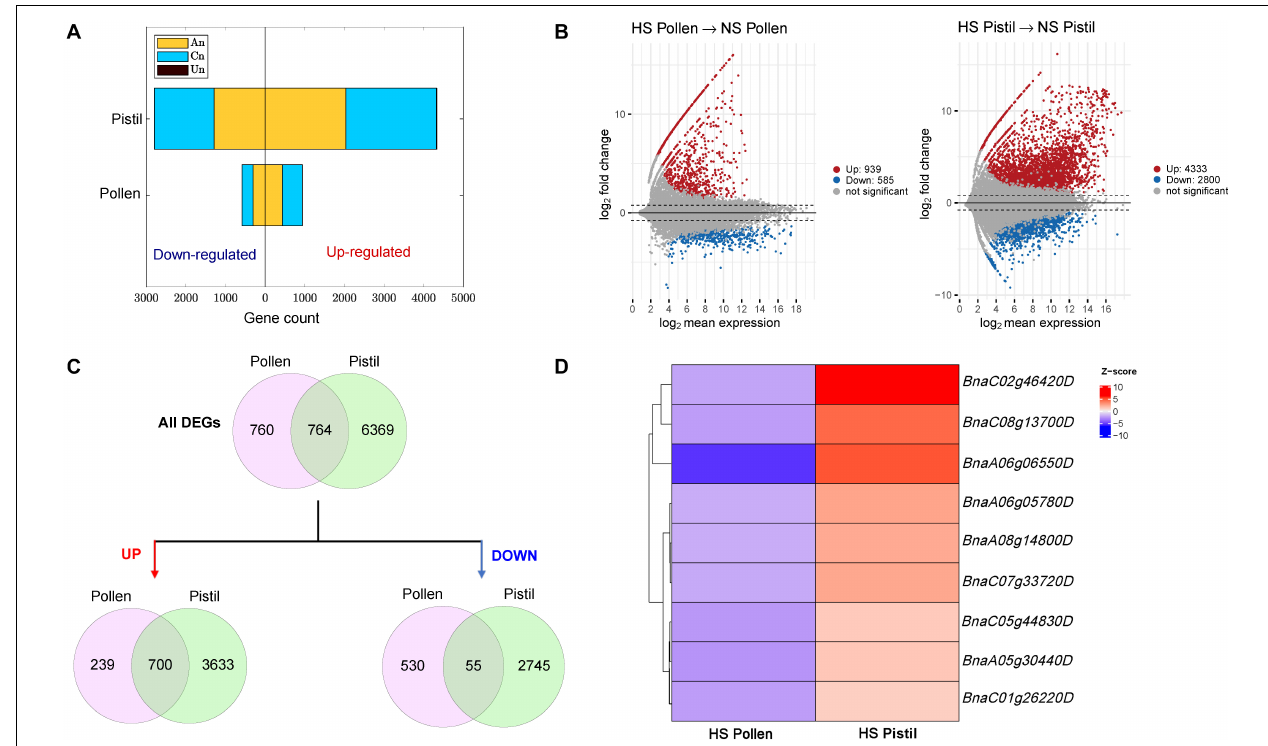
FIGURE 3 | Differential gene expression analysis. (A) Number of up and down-regulated gene in heat-stressed pollen and pistil and their distribution on the A n and C n subgenome (Un represents genes located on uncertain chromosomes. (B) MA Plot of the differentially expressed genes in heat-stressed pollen and pistil; red dots represent upregulated genes, blue dot represent downregulated genes; and gray dots represent non-significant genes. HS, heat stressed; NS, non-stressed. (C) Venn diagrams showing all shared DEGs, only upregulated shared DEGs and only down-regulated shared DEGs between heat-stressed pollen and pistil. (D) Details and expression levels of the shared DEGs with upregulated expression in heat-stressed pistil and downregulated expression in heat-stressed